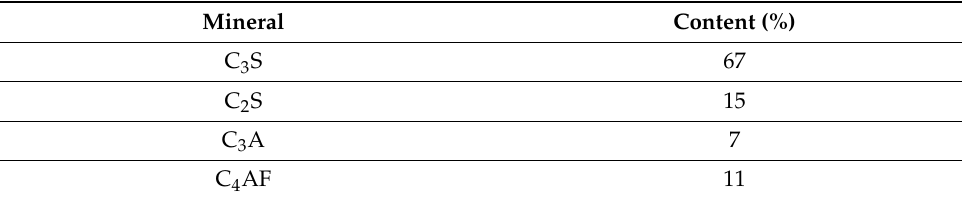
Table 1. Mineralogical composition of Portland cement.